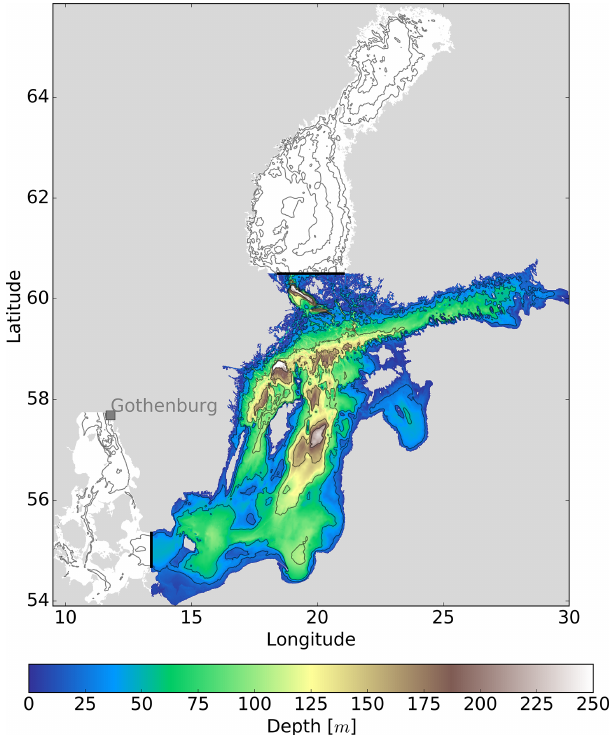
Figure 2. Map of the high-resolution model domain (filled col- ors) with the open boundary locations (black lines). The coarse- resolution model domain (blank contours + filled colors) has an open boundary close to the Gothenburg